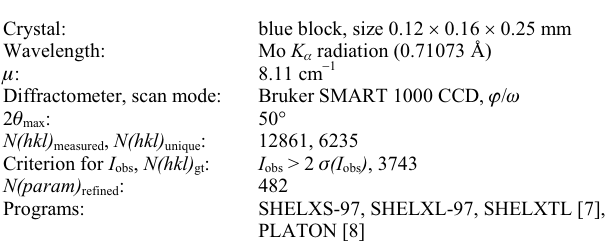
Table 1. Data collection and handling.